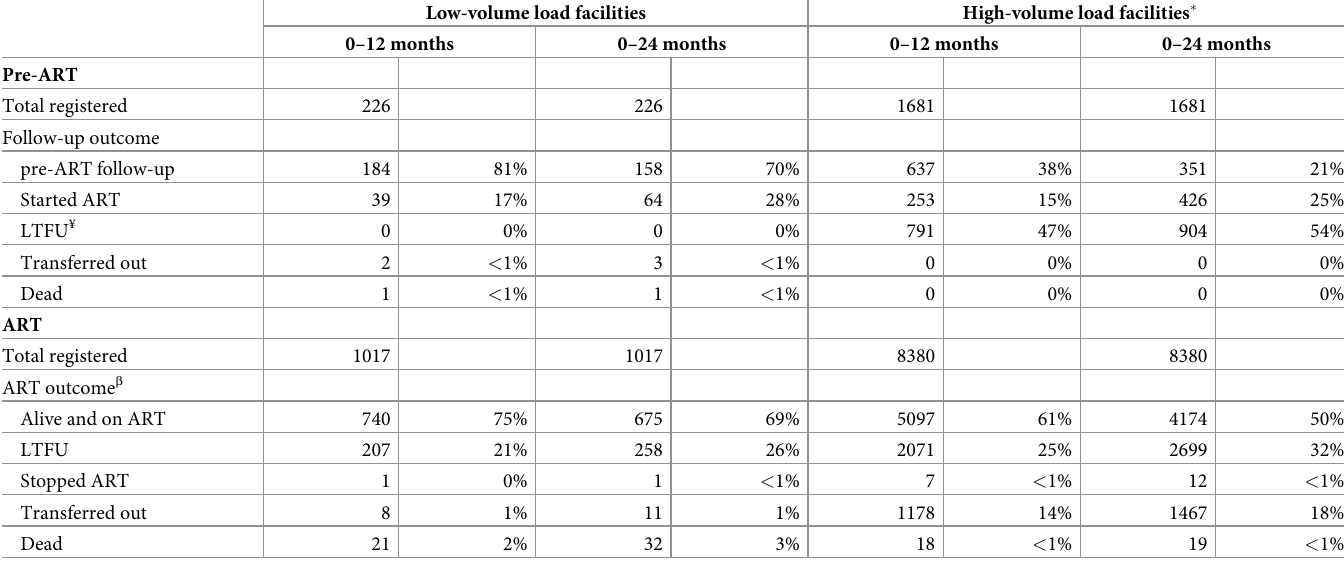
Table 2. ART program outcomes by time in HIV care among HIV-infected persons who registered for pre-ART and ART care between April 2012 and March 2013 in Lilongwe,